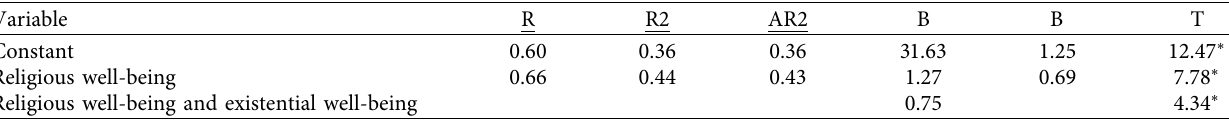
Duration of disease Marital status Education Gender P < 0 . 05. Table 3: Correlations between spiritual well-being and resilience ( N � 150). Variable 1 2 Resilience – Spiritual well-being 0.46 ∗ – ∗ Level of significance for all the values is P < 0 . 001. Table 4: A precis of the regression analysis results for predicting resilience based on spiritual well-being ( N � 150). Variable Constant Religious well-being Religious well-being and existential well-being ∗ Level of significance for all the values is P < 0 .